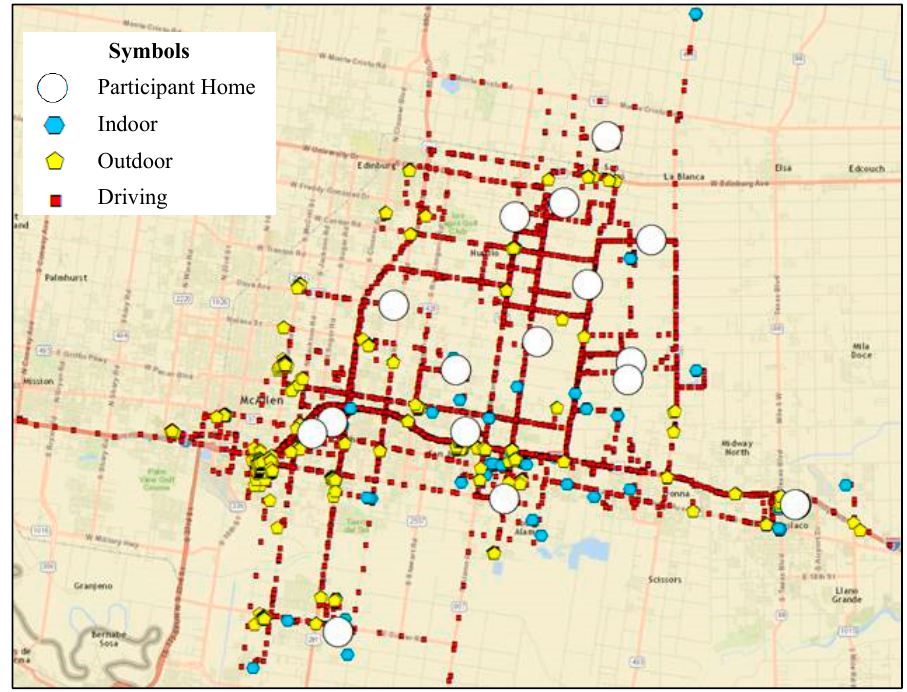
Figure 6. The time location trace from GPS coordinates for all 17 participants (50 sampling days).